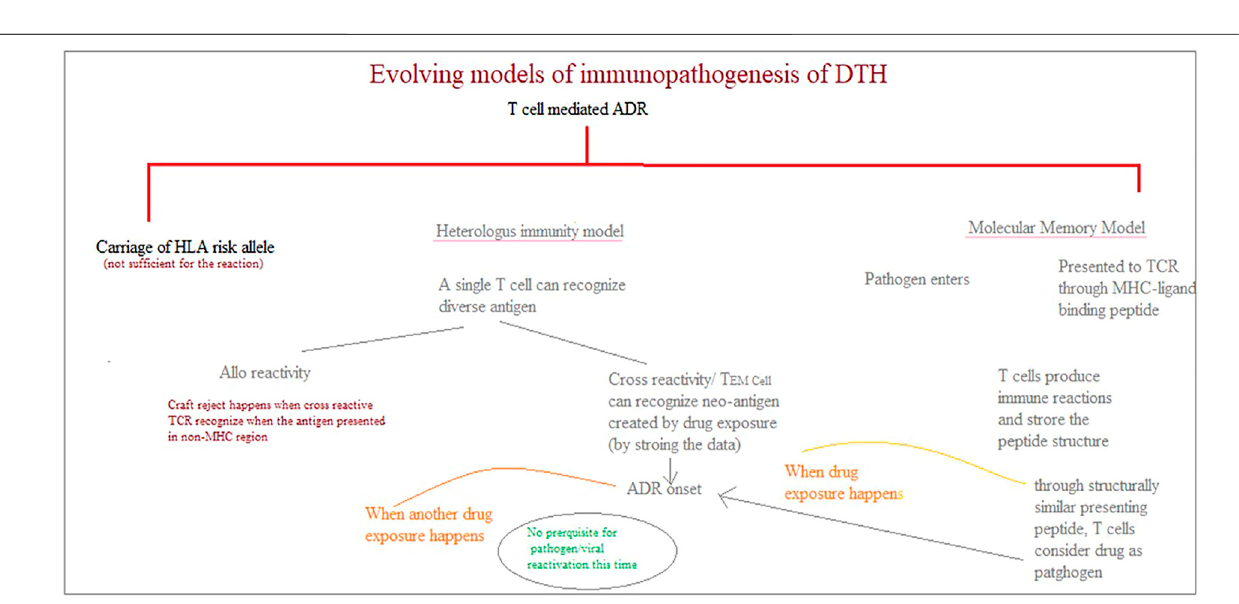
FIGURE 7 | Evolving models of immunopathogenesis of